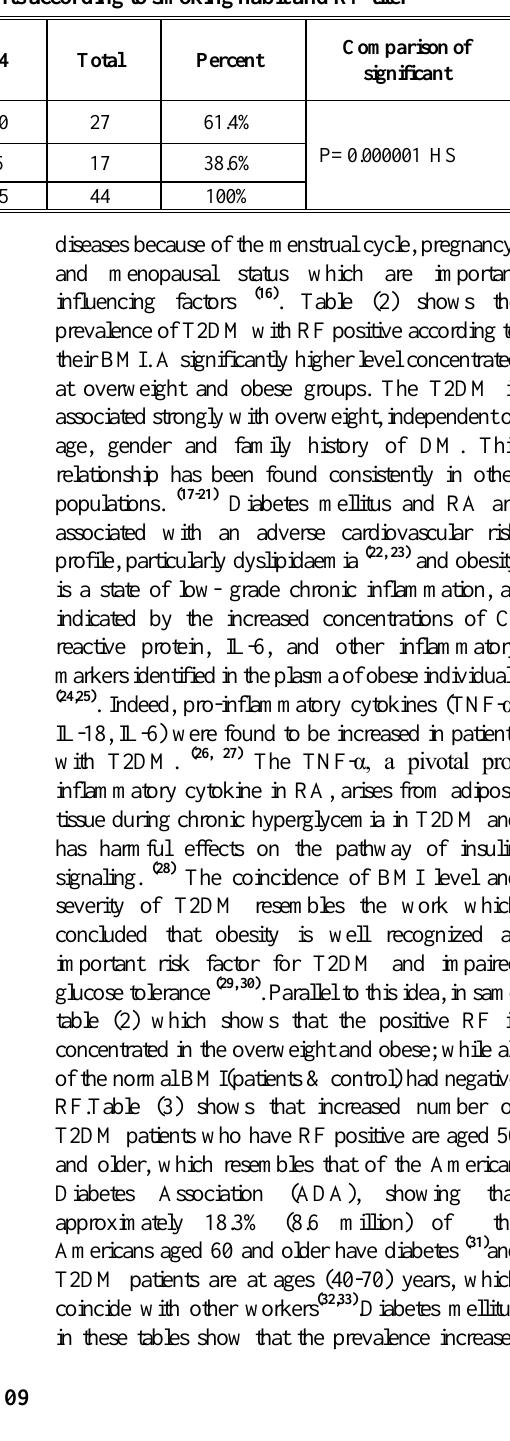
Table 7: Distribution of RF positive diabetic patients according to smoking habit and RF titer RF Titer IU/ml 8 16 32 64 Total Percent Smoke Positive 4 5 8 10